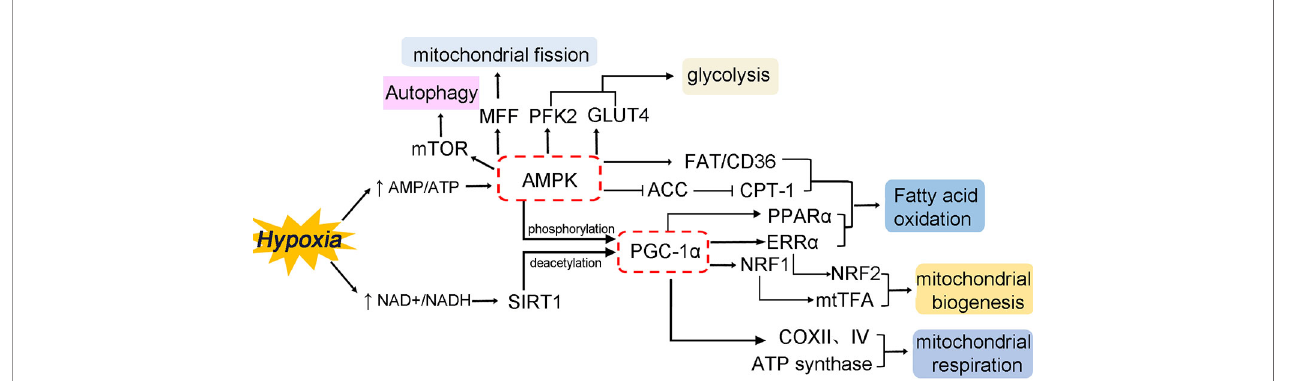
FIGURE 2 | Transcriptional control of cardiac energy metabolism in hypoxia/ischemia. The fi gure mainly summarizes the modulatory effects of AMPK and PGC- 1 a by multiple metabolic pathways and its interactions with nuclear receptors and transcription factors to regulate cardiomyocyte metabolism. The multiple physiological processes involve multiple aspects, including substrate preference, mitochondrial biogenesis, mitochondrial dynamics, mitochondrial autophagy, and mitochondrial